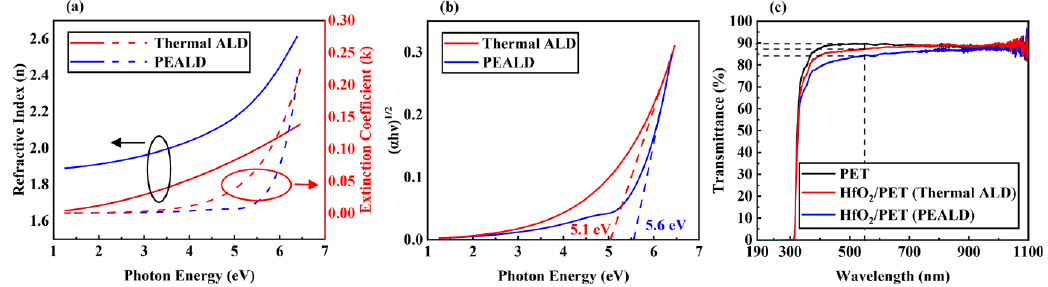
Figure 4. ( a ) Refractive index (n), extinction coefficient (k) and ( b ) optical bandgap values extracted